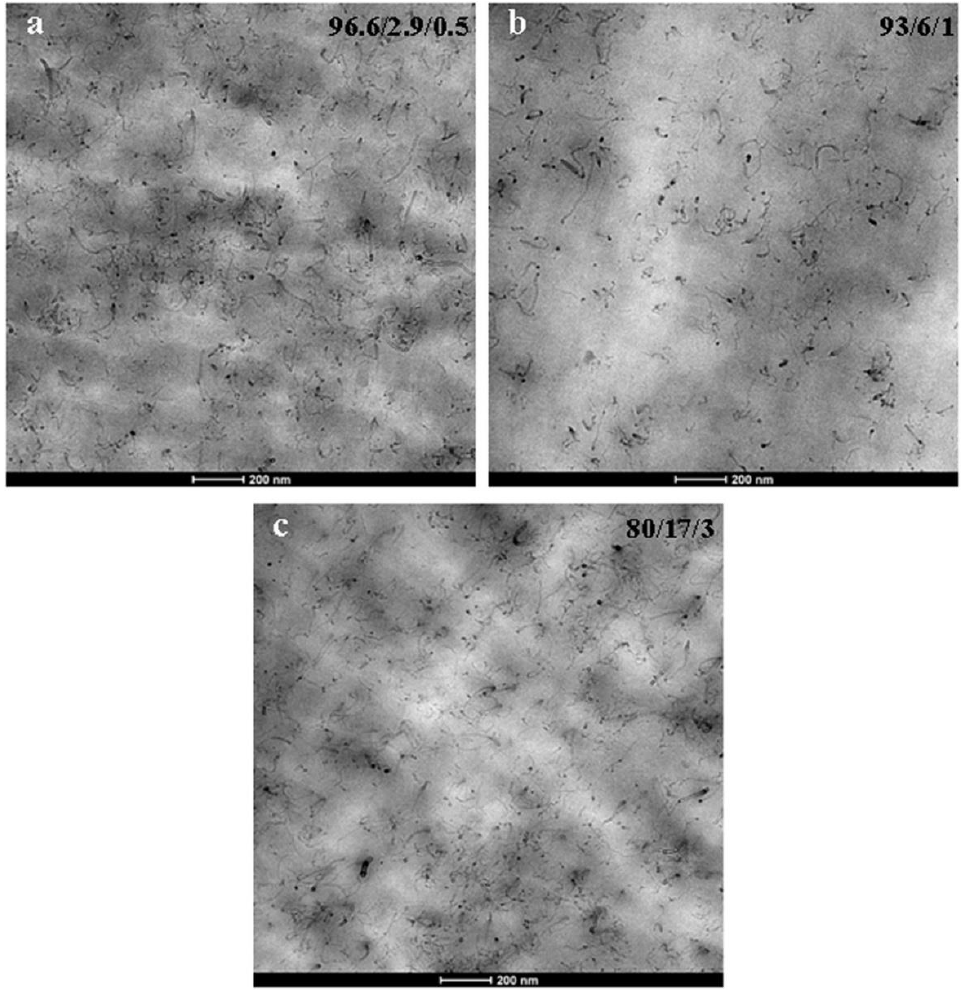
Figure 8. TEM micrographs of the 96.6/2.9/0.5 ( a ), 93/6/1 ( b ) and 80/17/3 ( c ) ternary PA410/PA6/CNT NCs at 25,000×